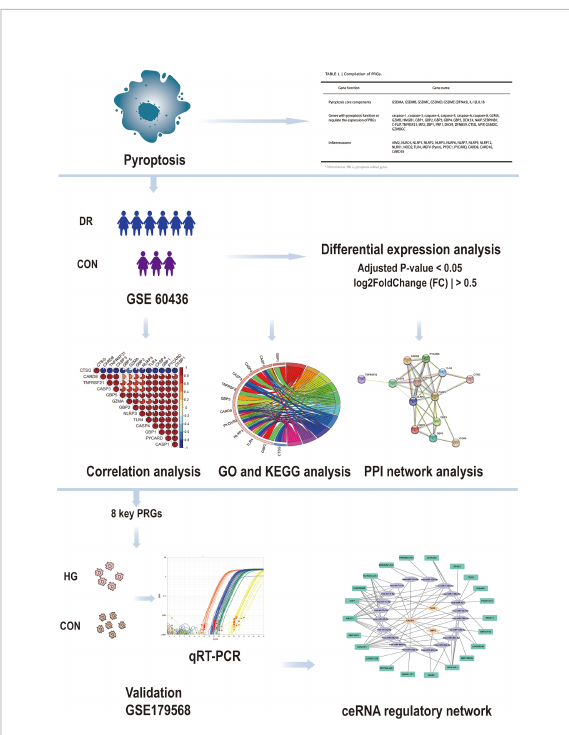
FIGURE 1 Design idea of this study. Downloaded GSE60436 dataset from the GEO database and 51 PRGs collected from the PubMed database. The R software was used to process the data, such as quality control, normalization, and background correction. A total of 13 differentially expressed PRGs in the dataset were identi fi ed by difference analysis, and GO and KEGG enrichment analyses were performed. At the same time, eight hub genes were identi fi ed by PPI analysis and then veri fi ed with qRT-PCR experiments and GSE179568. Finally, the speci fi c mechanism of PRGs in DR was revealed by structuring a ceRNA regulatory network through multiMiR database and starbase database. GEO, Gene Expression Omnibus; PRGs, pyroptosis-related genes; PPI, protein – protein interaction; DR, diabetic retinopathy; qRT-PCR, quantitative real-time polymerase chain reaction; ceRNA, competing endogenous RNAs; GO, Gene Ontology; KEGG, Kyoto Encyclopedia of Genes and